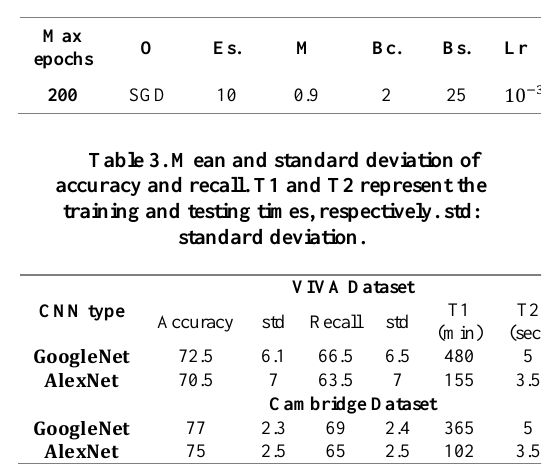
Table 2. Configuration of 3D networks.